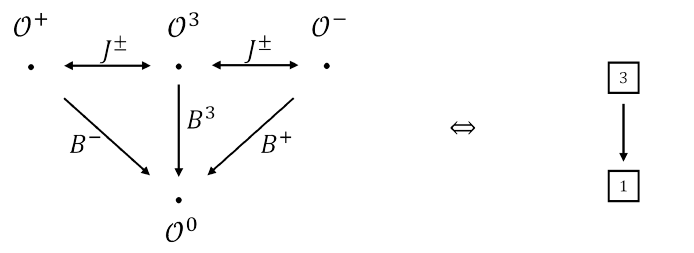
Figure 2: The vector representation of CCA rotation group. The meaning of this Young diagram structure will be introduced in section